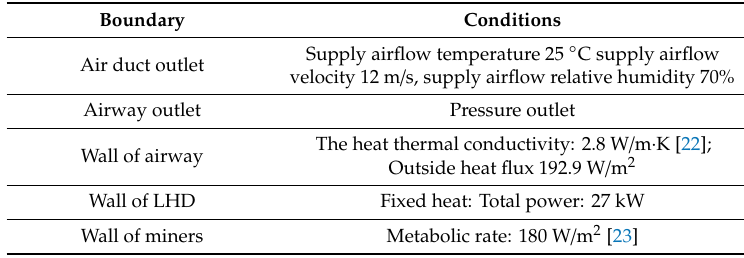
Table 4. Boundary conditions of the CFD